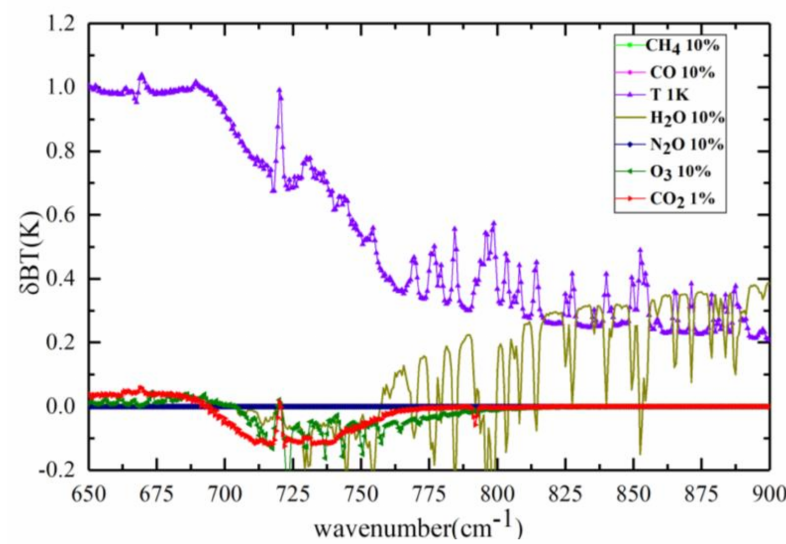
Figure 2. Sensitivities of Cross-track Infrared Sounder (CrIS) channels located in the long wave bands (650-900cm − 1 ) to variations of 10% CH 4 (green), 10% CO (pink), 10% N 2 O (navy blue), 10% O 3 (olive green), 10% H 2 O (deep yellow), 1 K temperature (violet), and 1% CO 2 (red).